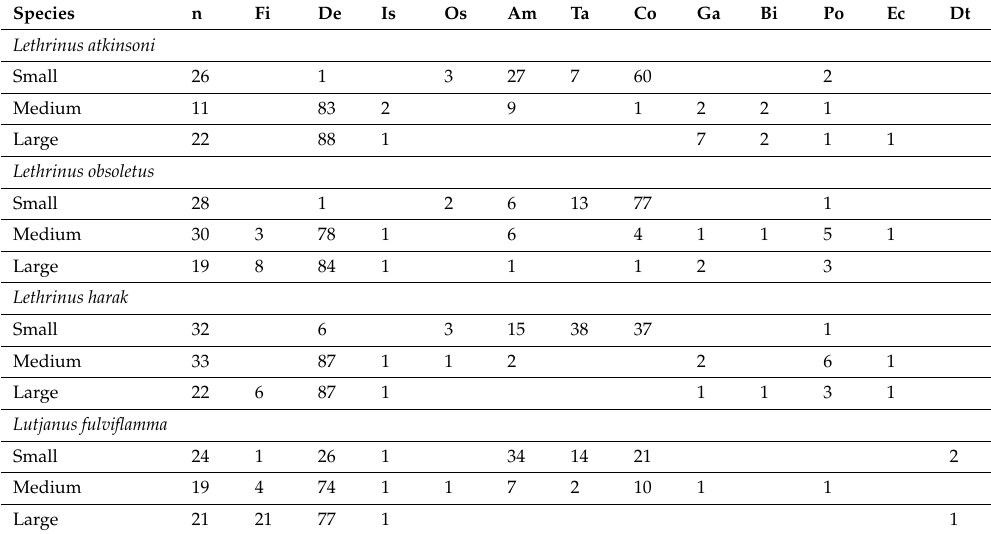
Table 3. Diet composition (V%) of the four target species in three different total length (small, medium, and large) categories (“n” = sample size). Abbreviations for food items: Fi: Fish, De: Decapod, Is: Isopod, Os: Ostracod, Am: Amphipod, Ta: Tanaid, Co: Copepod, Ga: Gastropod, Bi: Bivalve, Po: Polychaete, Ec: Echinoid, and Dt: